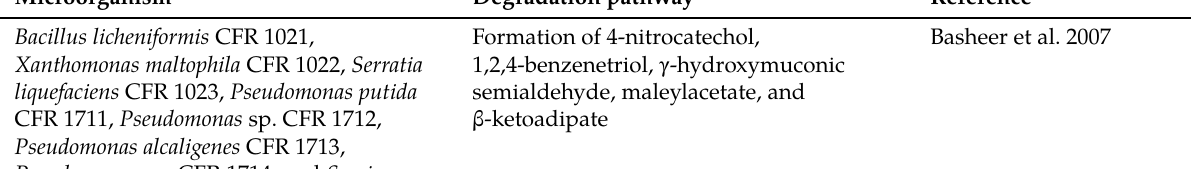
Table 4: Aerobic biodegradation of p -NP.